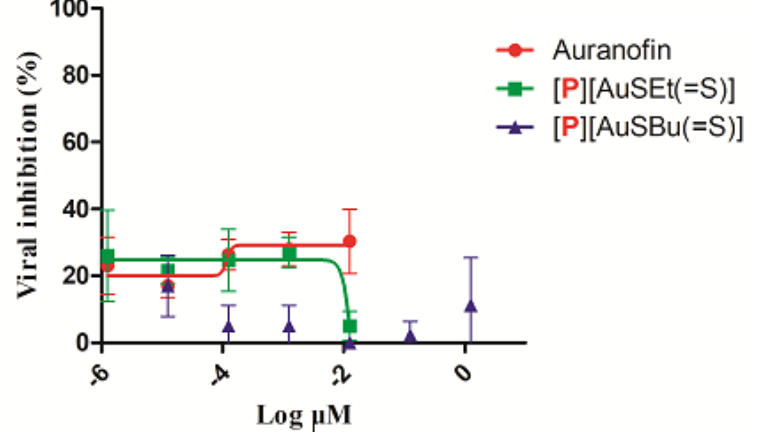
Figure 6. The activity of Auranofin, [ P ][AuSEt(=S)] and [ P ][AuSBu(=S)] in TZM-bl cells in a single- round infectivity assays against SG3.1 HIV-1 reference isolate.